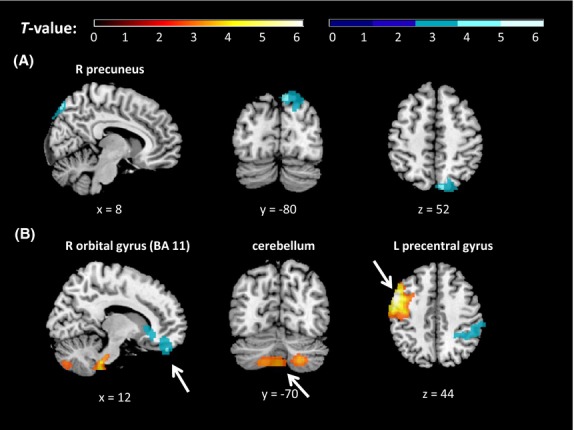
Results of whole-brain level analyses for the regressions between self-reported mood rating differences and regional cerebral blood flow (rCBF) differences for the contrasts (A) sad minus neutral, (B) happy minus neutral, overlaid on a T1-weighted structural brain image. Orange = positive correlation, blue = negative correlation. All locations are reported in MNI coordinates. For illustration purposes, the cluster-level significance is P < 0.05 (AlphaSim corrected). BA, Brodmann area; L, left; R, right.